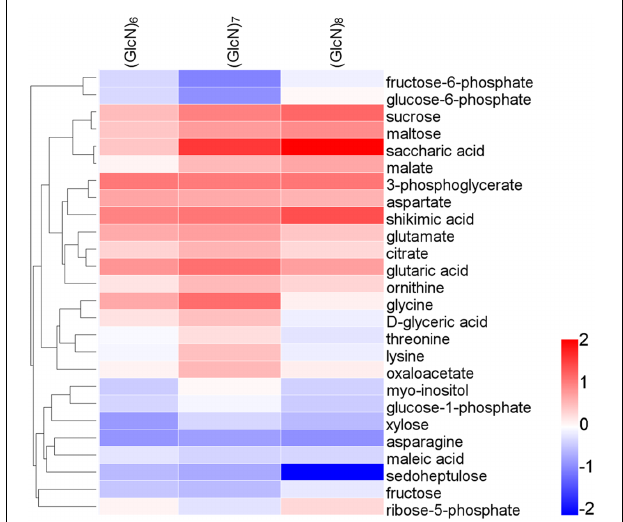
FIGURE 2 | Changes of metabolite levels after spraying wheat seedlings with (GlcN) 6 , (GlcN) 7 , and (GlcN) 8 . Metabolite levels are normalized on the average level in CK, transformed to log 2 ratios, and then converted to a false color scale as indicated in the legend scale (six biological replicates). This procedure means that metabolites that increase in chitosan-treated seedlings are colored in red, and metabolites decreased in chitosan-treated seedlings are colored in blue. Metabolites with no change are colored in